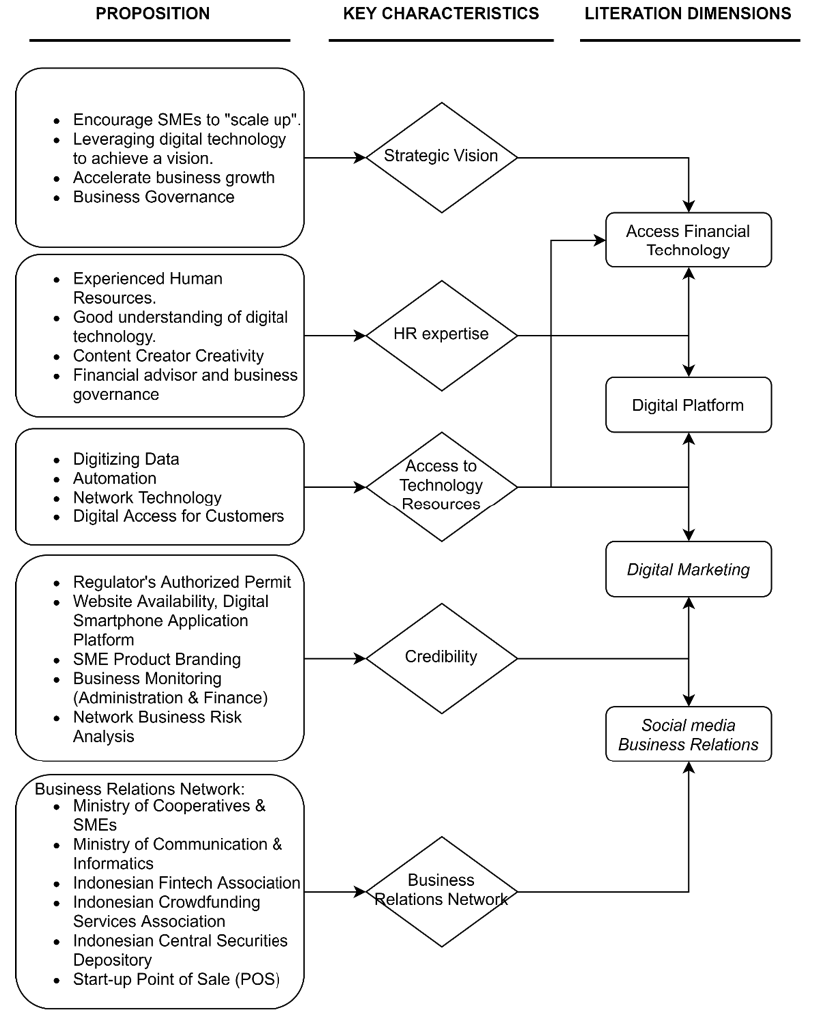
Figure 2: Data structures are a key characteristics in encouraging digital